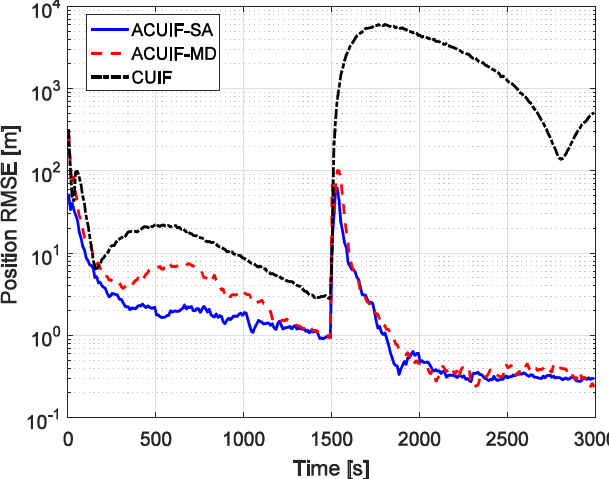
Figure 7. The position RMSE for different methods over time with 10 observation platforms.